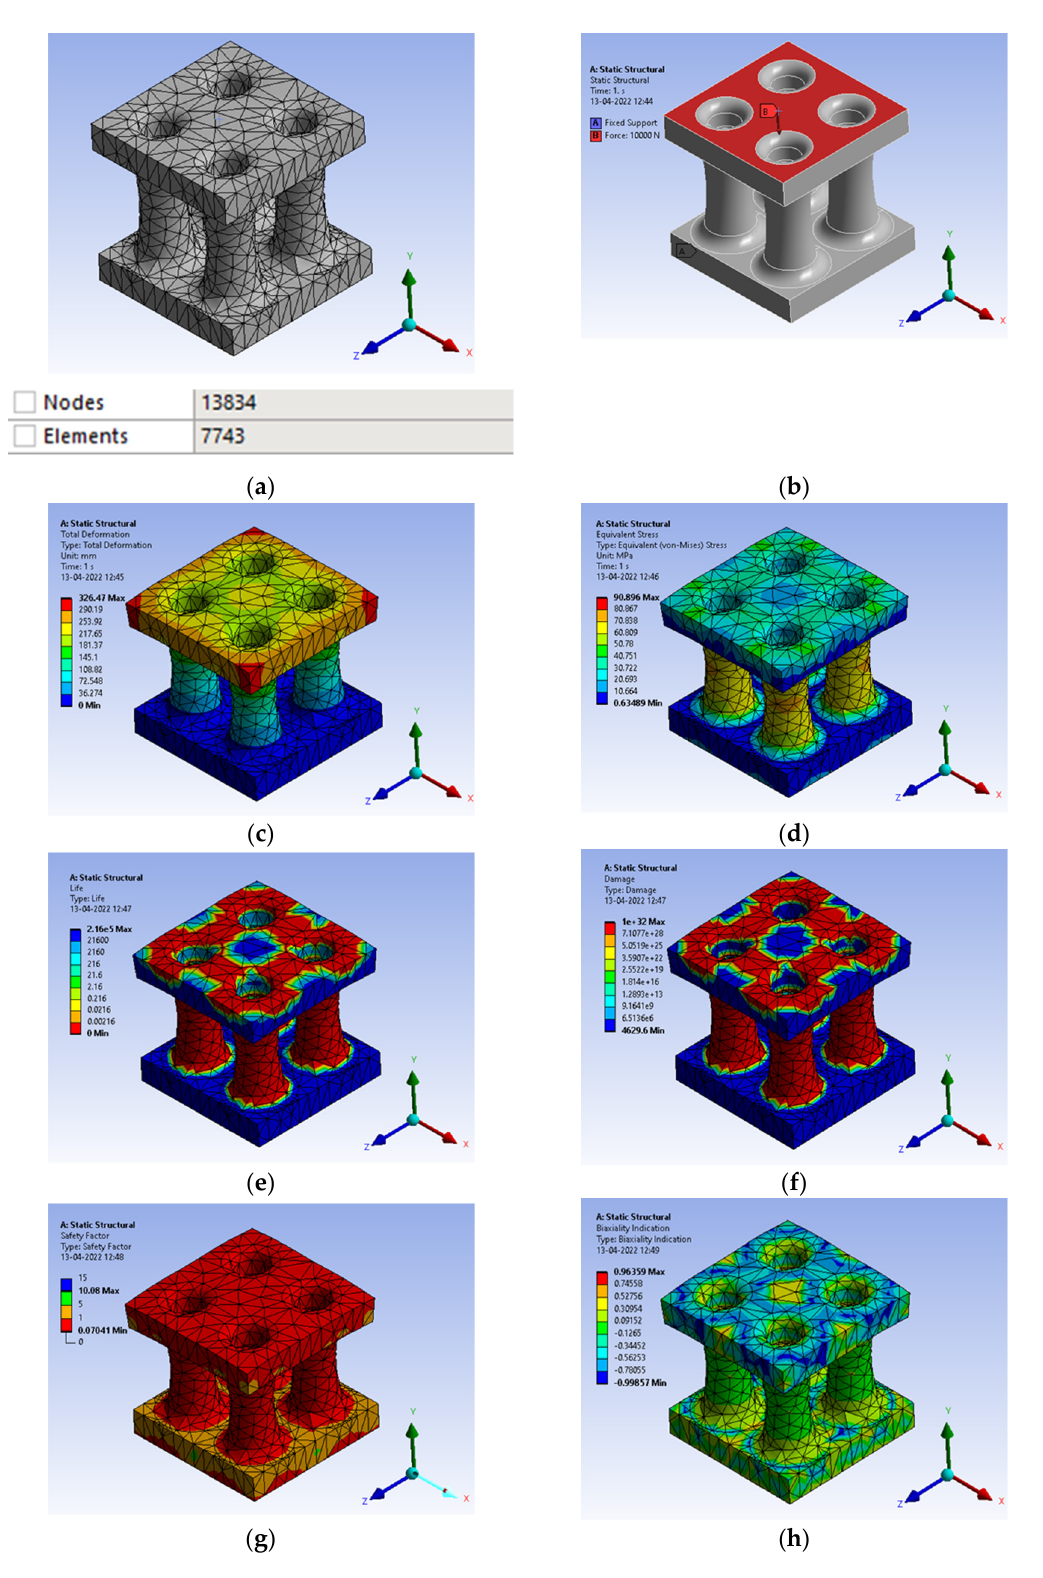
Figure 15. ( a ) Mesh generation; ( b ) Loads and boundary conditions; ( c ) Total deformation; ( d ) Von mises stress; ( e ) Life cycle; ( f ) Damage; ( g ) Factor of safety; ( h ) Biaxiality indication.